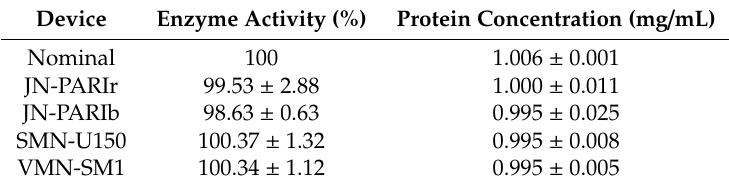
Table 4. Dornase alfa activity and concentrations of nebulized samples expressed as percentages of non-nebulized